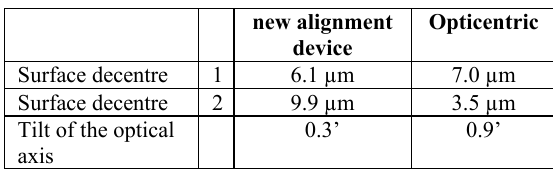
Table 2. Decentre measurement of the second lens with respect to the optical axis of the first